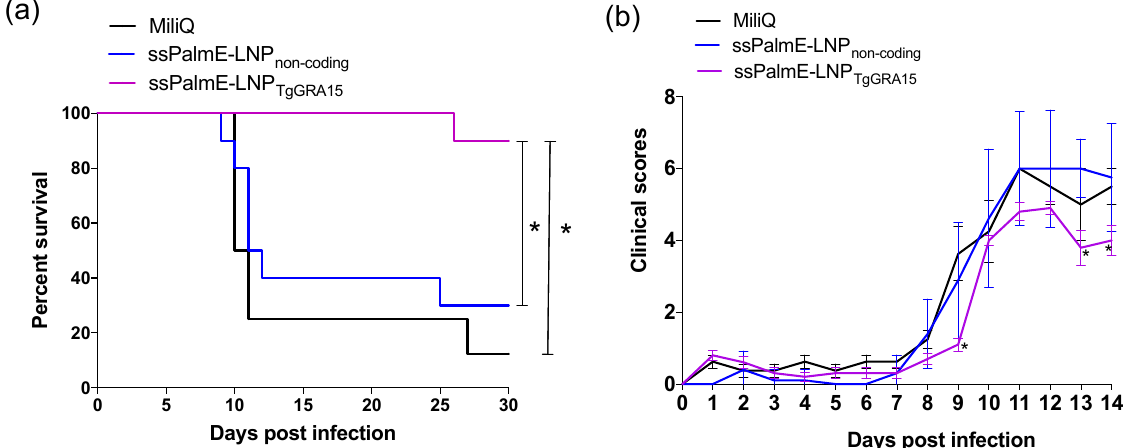
Figure 1. Survival rates and clinical scores of immunized mice after challenge with T. gondii . The mice were immunized with ssPalmE-LNP TgGRA15 ( n = 10), ssPalmE-LNP non-coding ( n = 10), or Milli-Q water ( n = 8), and then challenged with the PLK strain of T. gondii . ( a ) Survival curves were generated using the Kaplan–Meier method. *, The significance of differences in mouse survival was analyzed by the log-rank test. The differences were significant between Milli-Q water-injected and ssPalmE-LNP TgGRA15 -immunized groups, and ssPalmE-LNP non-coding -injected and ssPalmE-LNP TgGRA15 -immunized groups (* p < 0.05). ( b ) Clinical scores were monitored daily up until 14 days after T. gondii infection. The mean ± SD represents the average clinical score values of all mice in each group. Statistical significance was determined by two-way ANOVA and Bonferroni post hoc analysis ( * p < 0.05) for ssPalmE-LNP TgGRA15 -immunized groups compared with the ssPalmE-LNP non-coding -injected and Milli-Q water-injected groups.